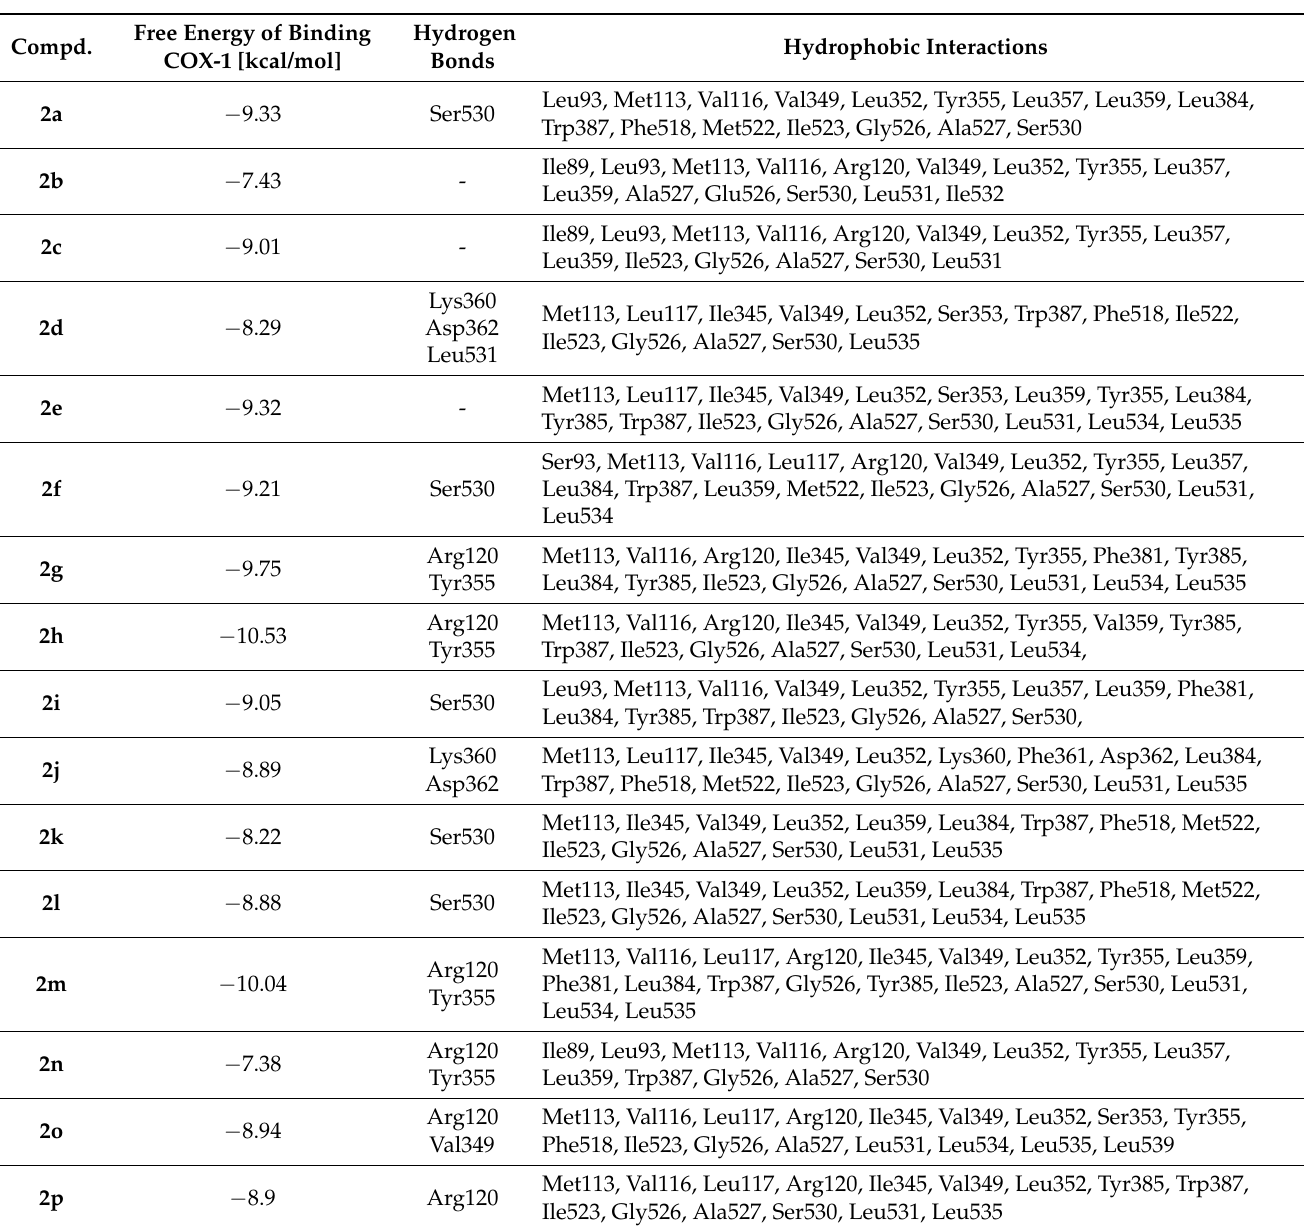
Table 4. Free energy of binding and binding mode of all considered compounds to COX-1.